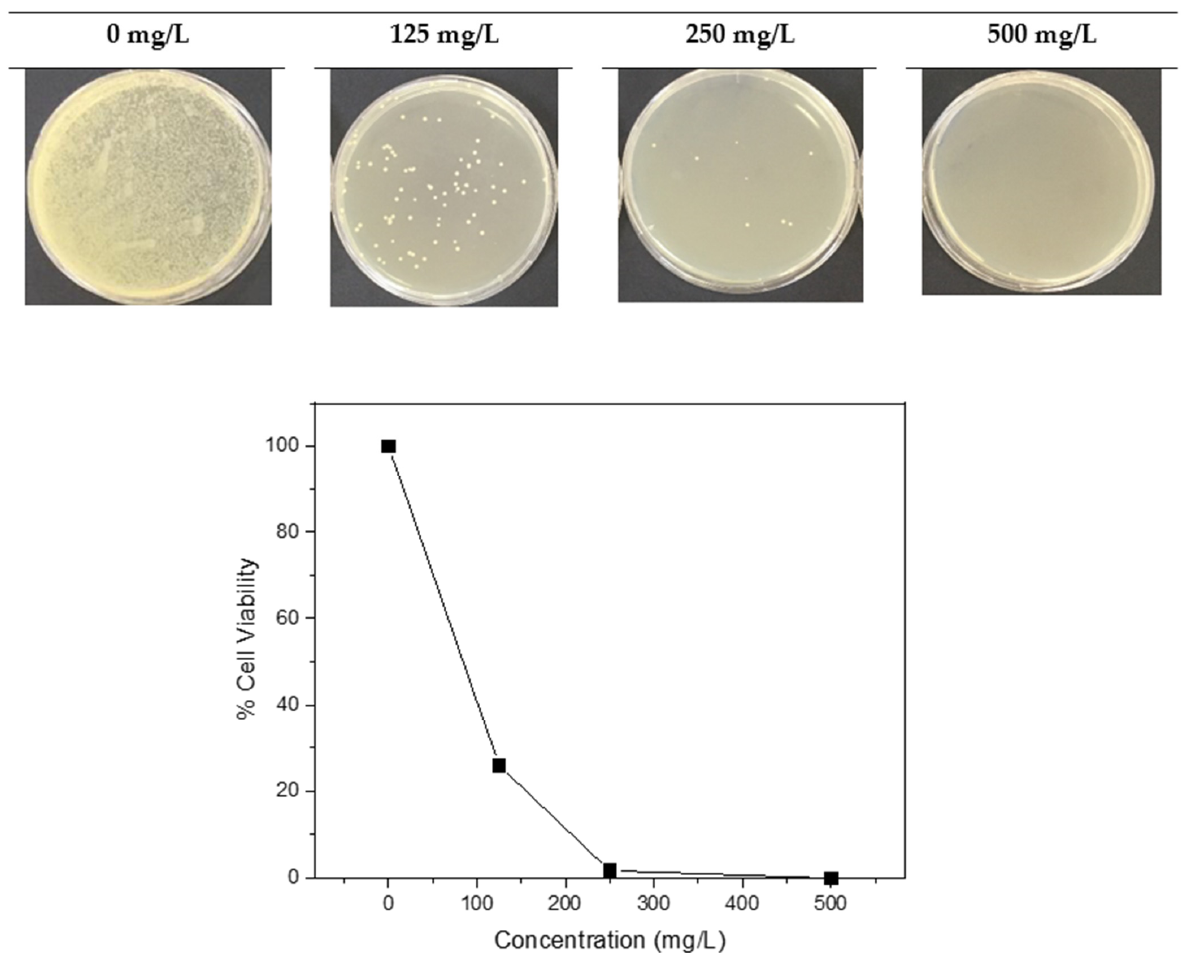
Figure 5. Microbial cell